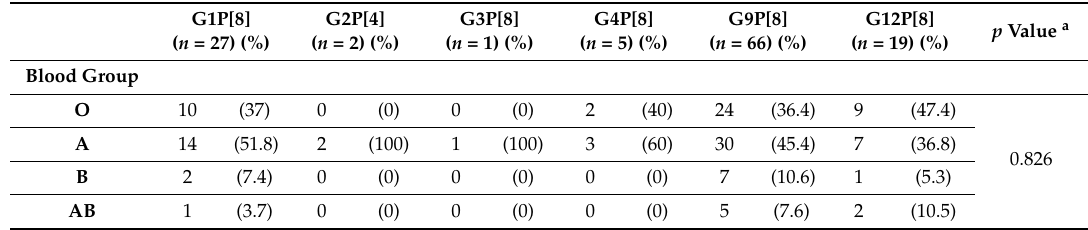
Table 2. Association between ABO blood group, secretor status (secretor, heterozygous/homozygous, non-secretor), and Lewis phenotypes with the infecting G/P rotavirus